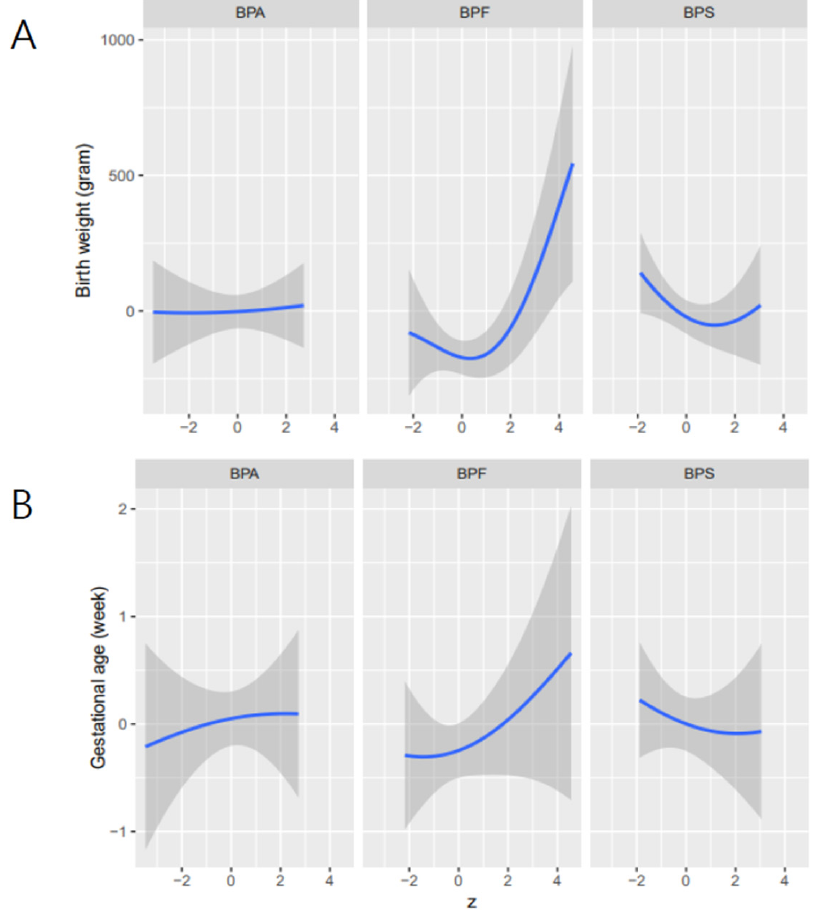
Figure 1. Univariate exposure–response functions and 95% credible intervals for each bisphenol (BPA, BPF, BPS) and the birth weight ( A ) and gestational age ( B ) when the other bisphenols are fixed at their medians, respectively. These results were estimated by Bayesian kernel machine regression. Models were adjusted for maternal age, education, family income, smoking status, drinking status, body mass index, exercise, parity, infant sex, and gestational weeks (only in the case of birth weight).